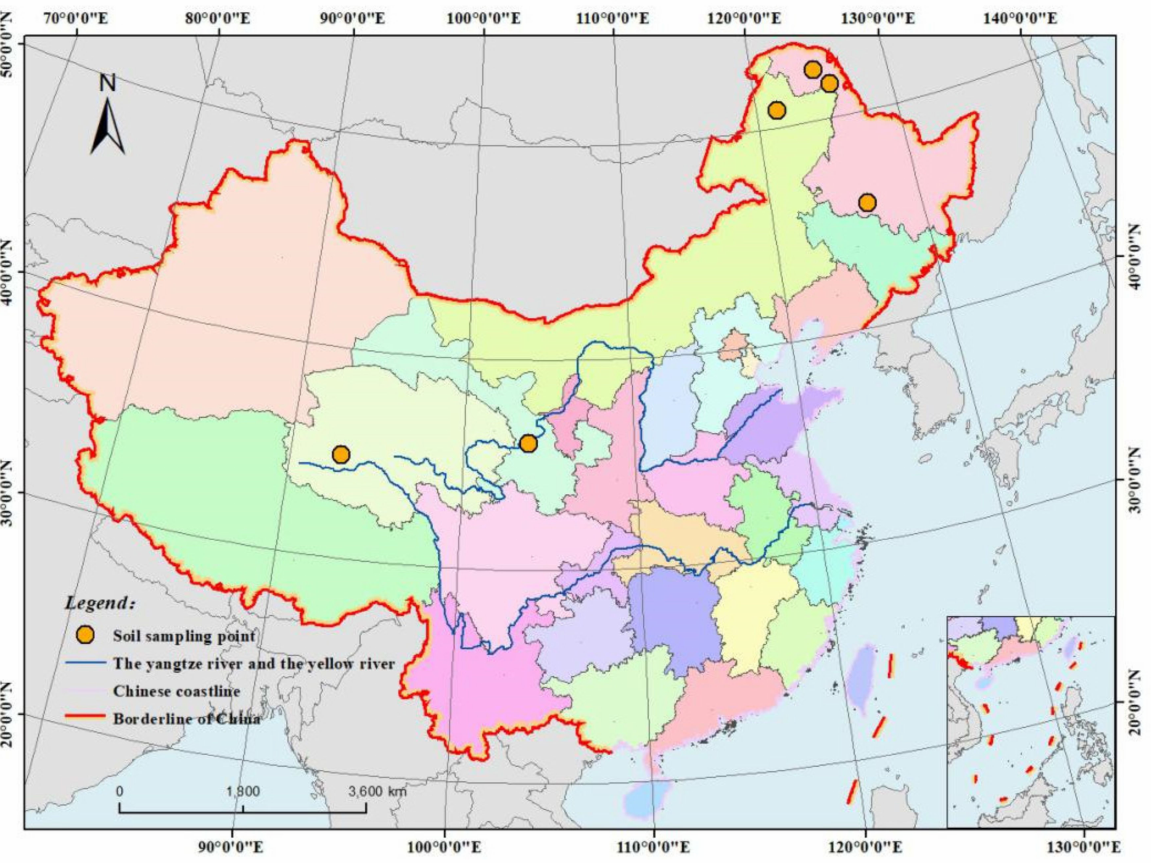
Figure 1. Geographical distribution of experiment